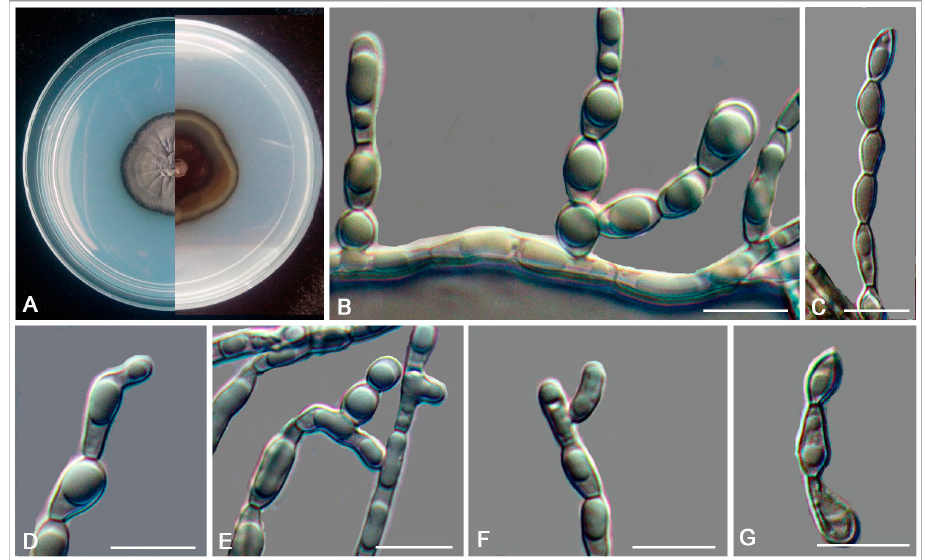
Figure 18. Cladophialophora tengchongensis (CGMCC 3.15201). ( A ) Forward (left) and reverse (right)